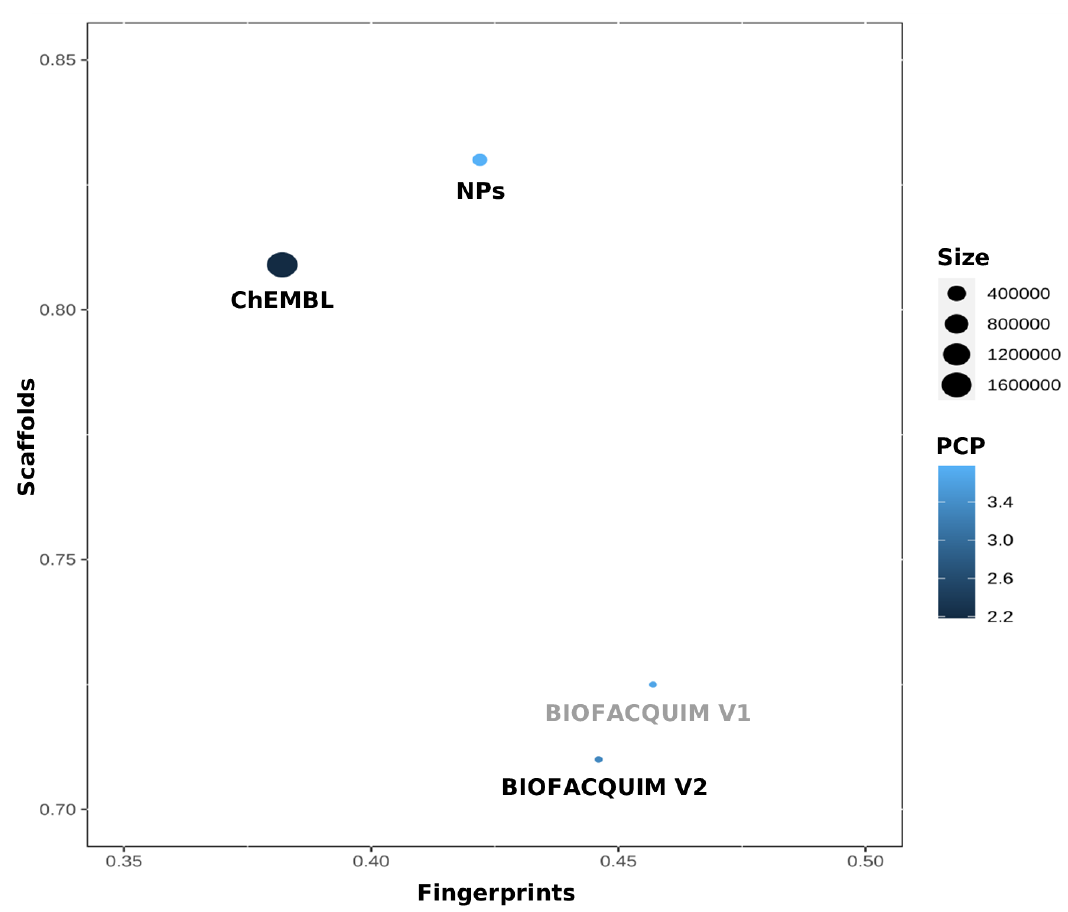
Figure 5. Consensus diversity plot of